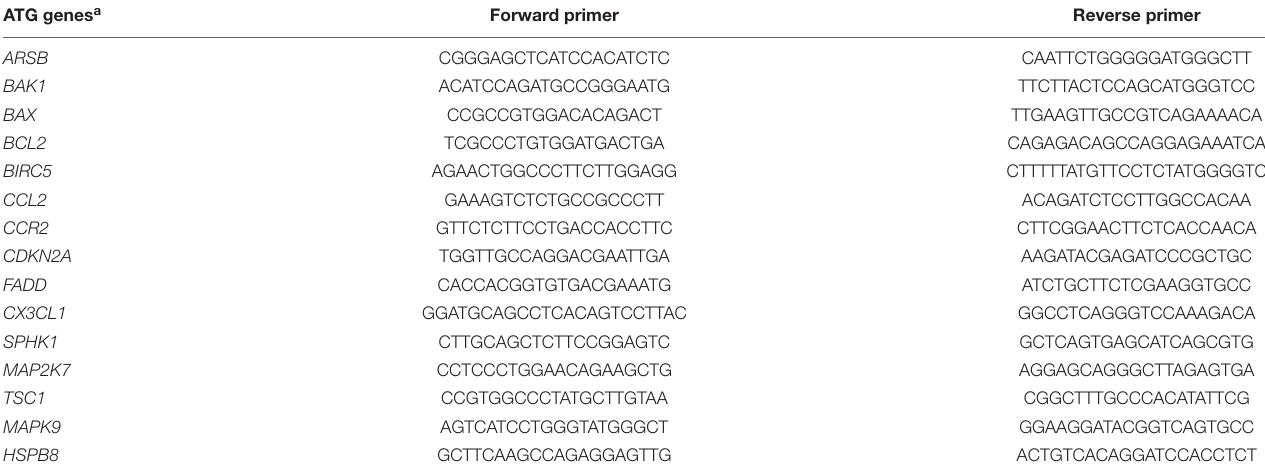
TABLE 3 | The primer sequences of 15 autophagy-related (ATG) genes used in quantitative real-time polymerase chain reaction (qRT-PCR) analysis. ATG genes a Forward